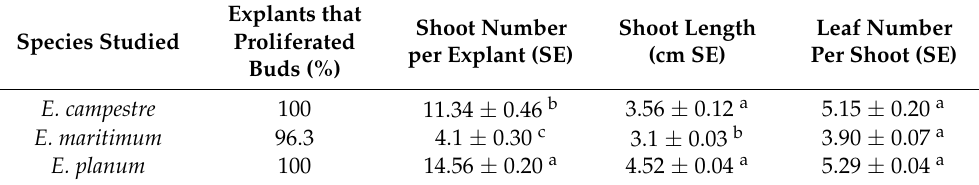
Table 1. The growth parameters of stabilized in vitro shoot cultures of Eryngium species. Explants that Species Studied